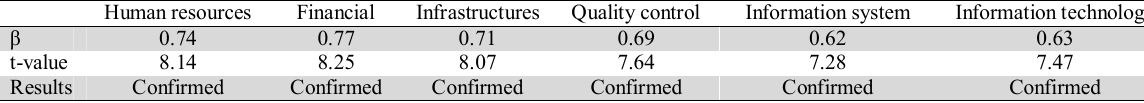
The summary of testing sub-hypotheses of the